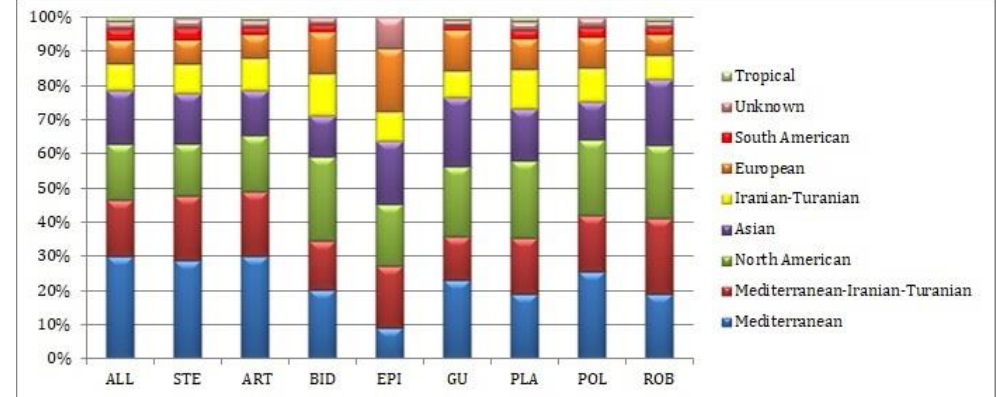
Fig. 5. Distribution of alien species in ruderal vegetation by origin